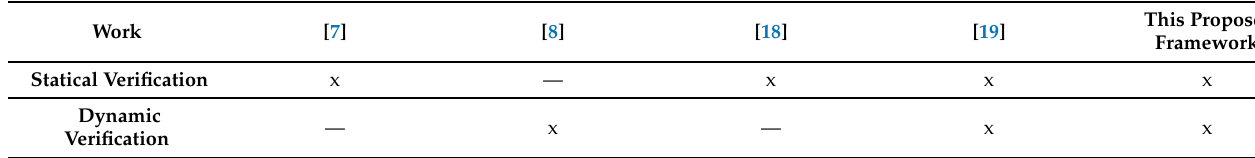
Table 19. Comparative summary of the characteristics of the proposed framework and related work.